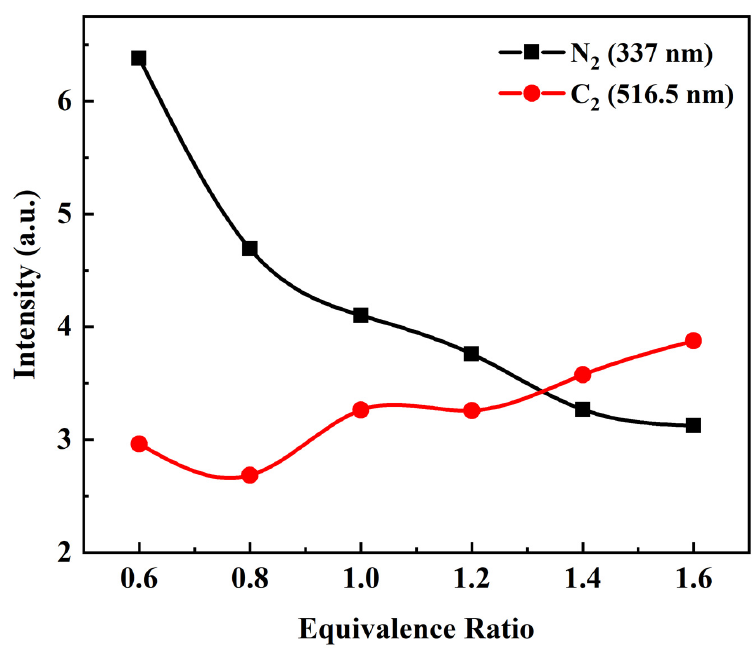
Figure 4. Variation curves of N 2 (337 nm) and C 2 (516.5 nm) signal intensities with equivalence ratio.